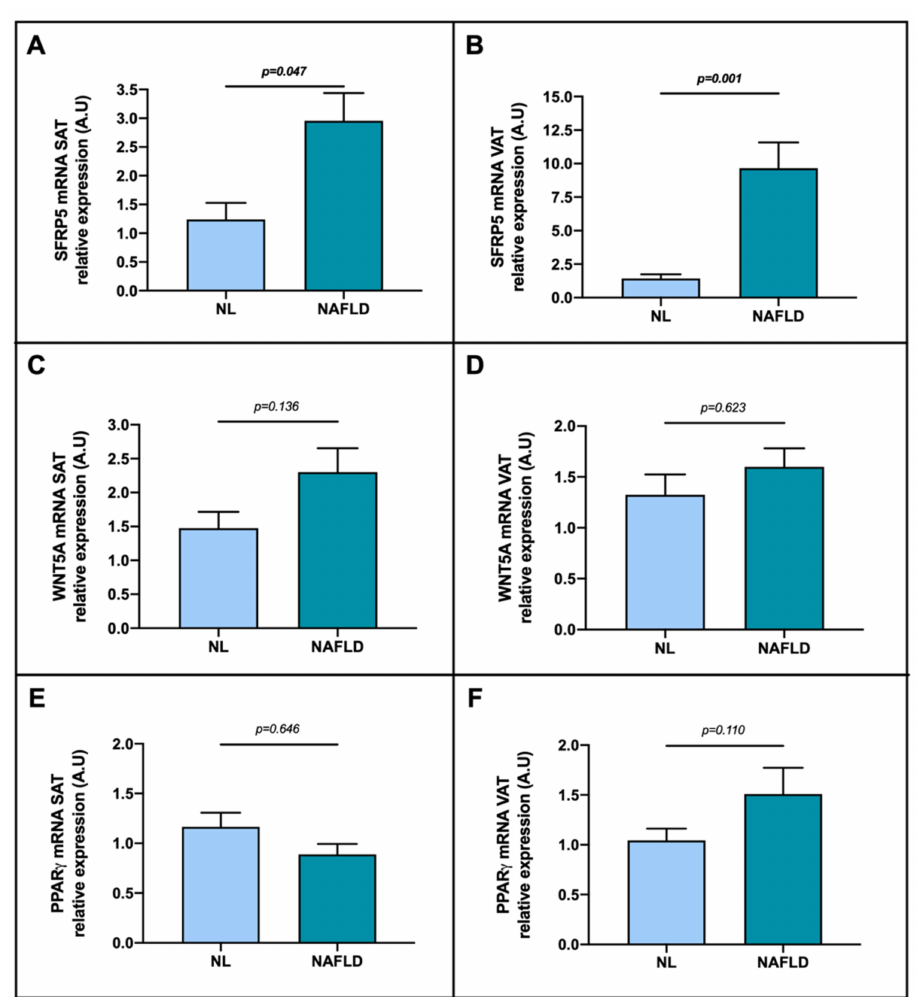
Figure 4. Differential relative mRNA abundance of ( A ) SFRP5, ( C ) WNT5A and ( E ) PPAR γ in subcutaneous adipose tissue and ( B ) SFRP5, ( D ) WNT5A and ( F ) PPAR γ in visceral adipose tissue of women with MO classified depending on NAFLD presence into NL or NAFLD. The data were normalized by NL group and expressed as mean standard error of the mean (SEM). SAT, subcutaneous adipose tissue; VAT, visceral adipose tissue; SFRP5, secreted frizzled-related protein 5; WNT5A, WNT family member 5a; PPAR γ , peroxisome proliferator-activated receptor gamma; NW, normal weight; MO, morbid obesity; A.U arbitrary units. p < 0.05 was considered statistically significant